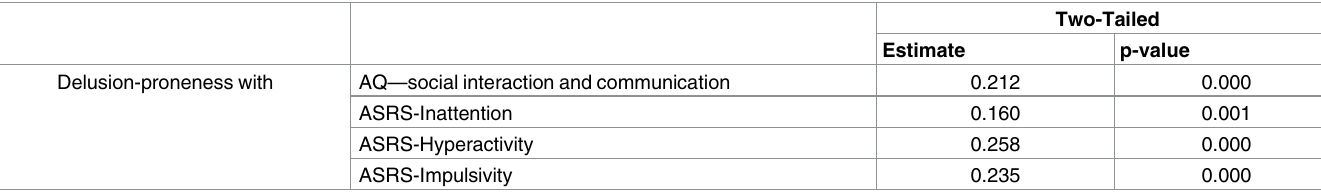
Table 5. Significant correlations between the PDI-factor and three other factors (from 5-factor model analysis on the truncated